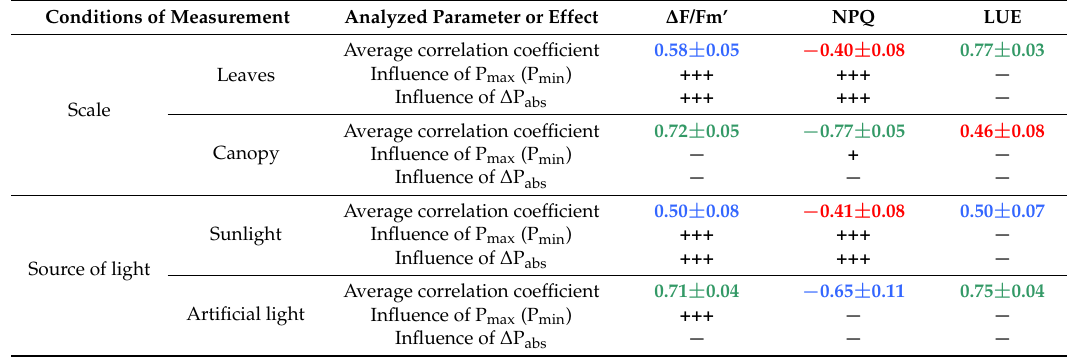
Table 2. Average correlation coefficients of the photochemical reflectance index with photosynthetic parameters and influence of distribution of these parameters among investigated plants on the connection between PRI and ∆ F/F m ’, NPQ, and LUE with different conditions of measurements. Conditions of